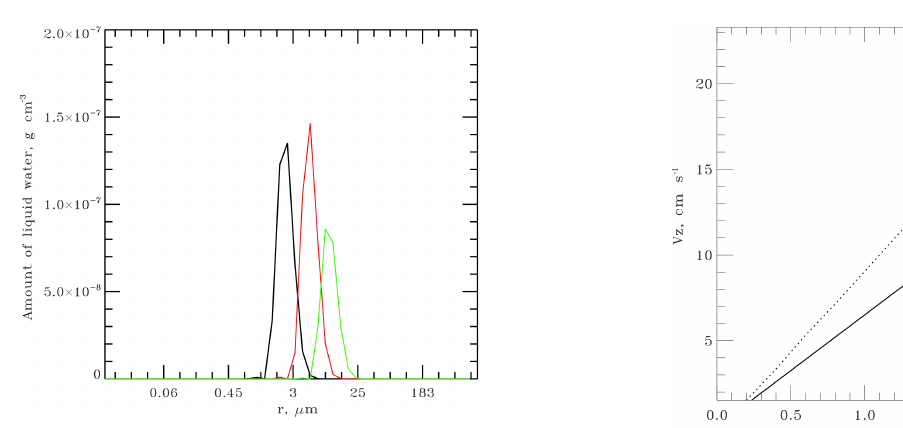
Figure 6. Averaged vertical velocity as a function of time with aerosol for N tot = 5500cm − 3 (dotted curve, case 3) and without aerosol (solid curve, case 5). Non-equilibrium case with low inten- sive turbulence is considered (see Table 3).